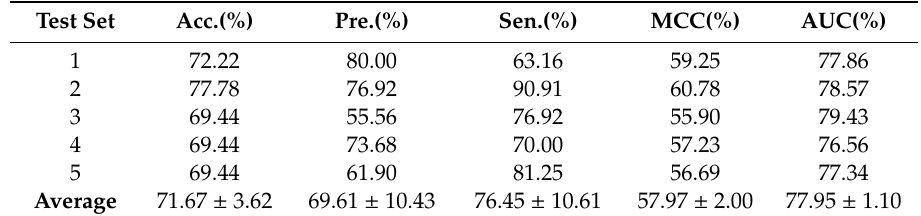
Table 4. The five-fold cross-validation results achieved on nuclear receptor dataset by using the proposed